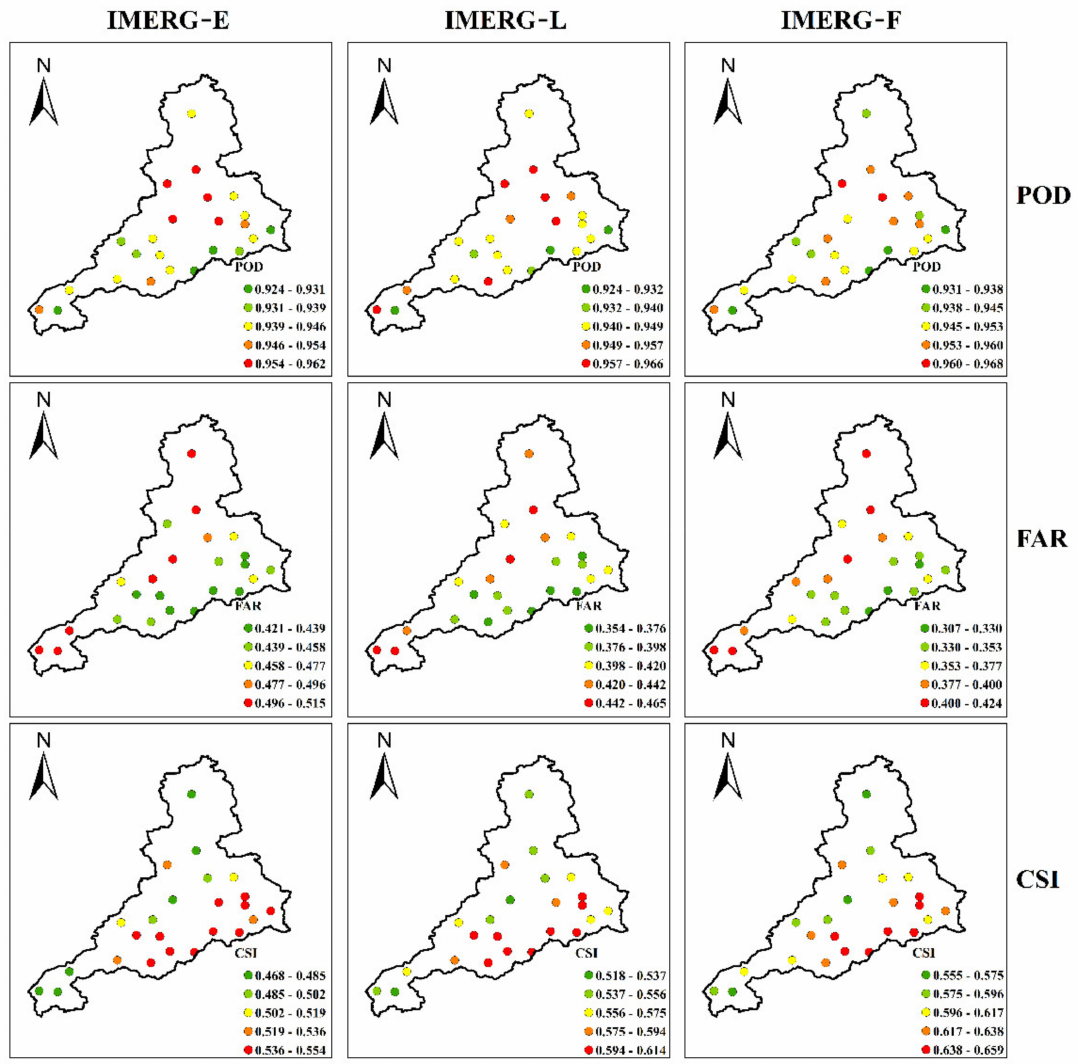
Figure 6. Spatial distributions of categorical verification statistics (POD, FAR, CSI) for IMERG